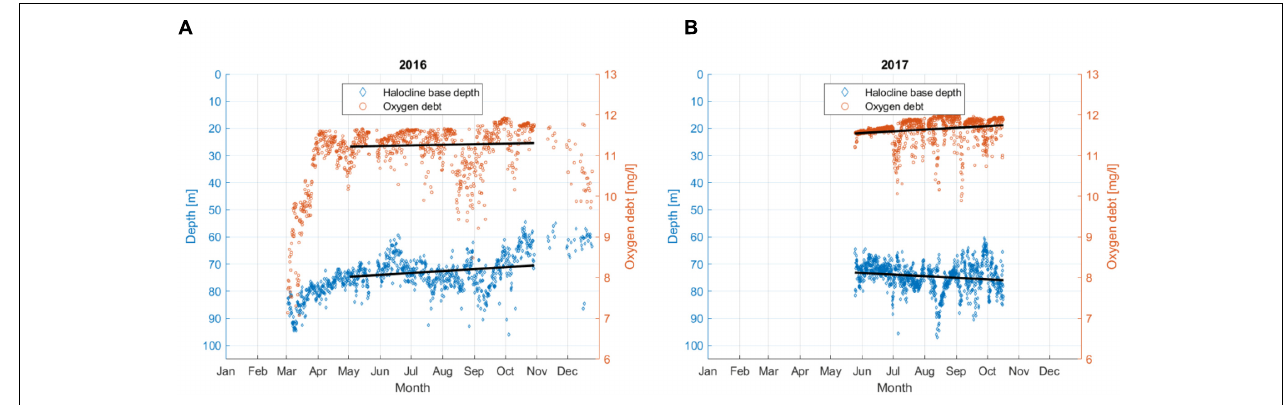
FIGURE 7 | Oxygen debt just below the halocline and the depth of the halocline base at the Keri station in the GoF based on all available data in 2016 (A) and 2017 (B) . Linear approximations of both parameters for the period from May to October are shown as the black lines, but the trends were not significant.